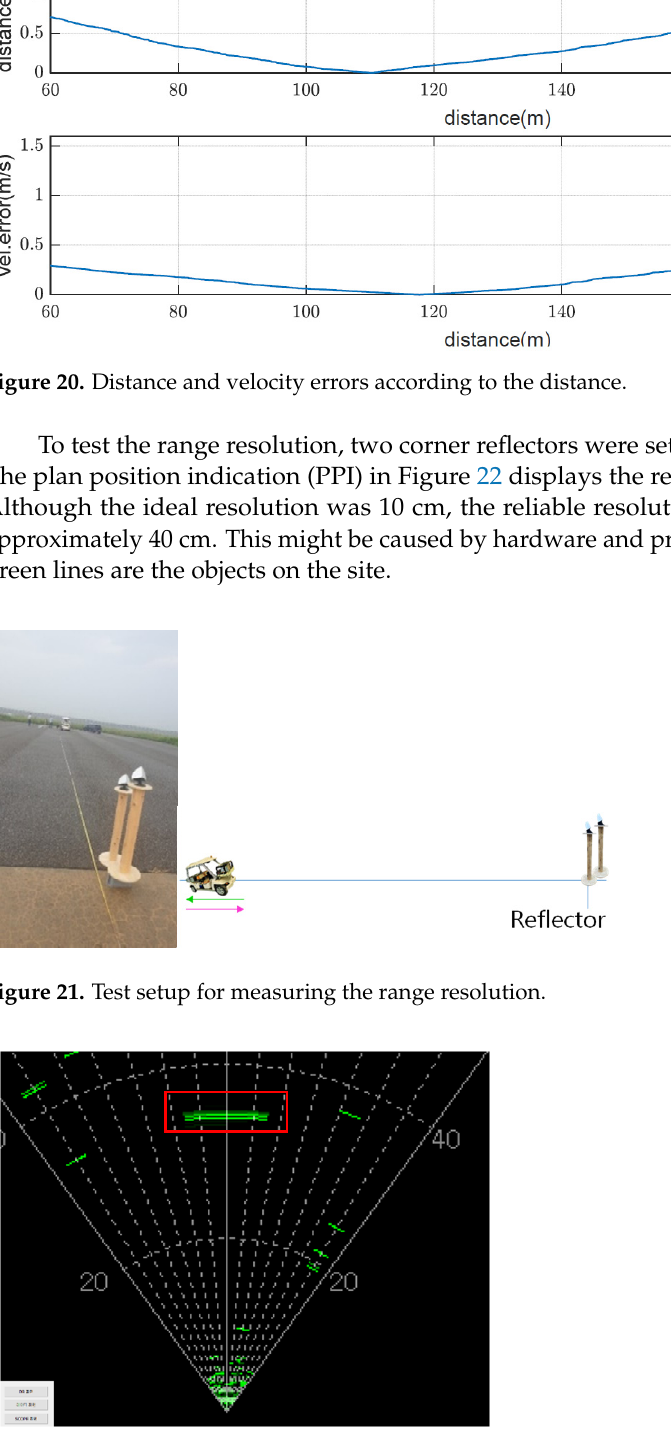
Figure 22. PPI display showing the range resolution.